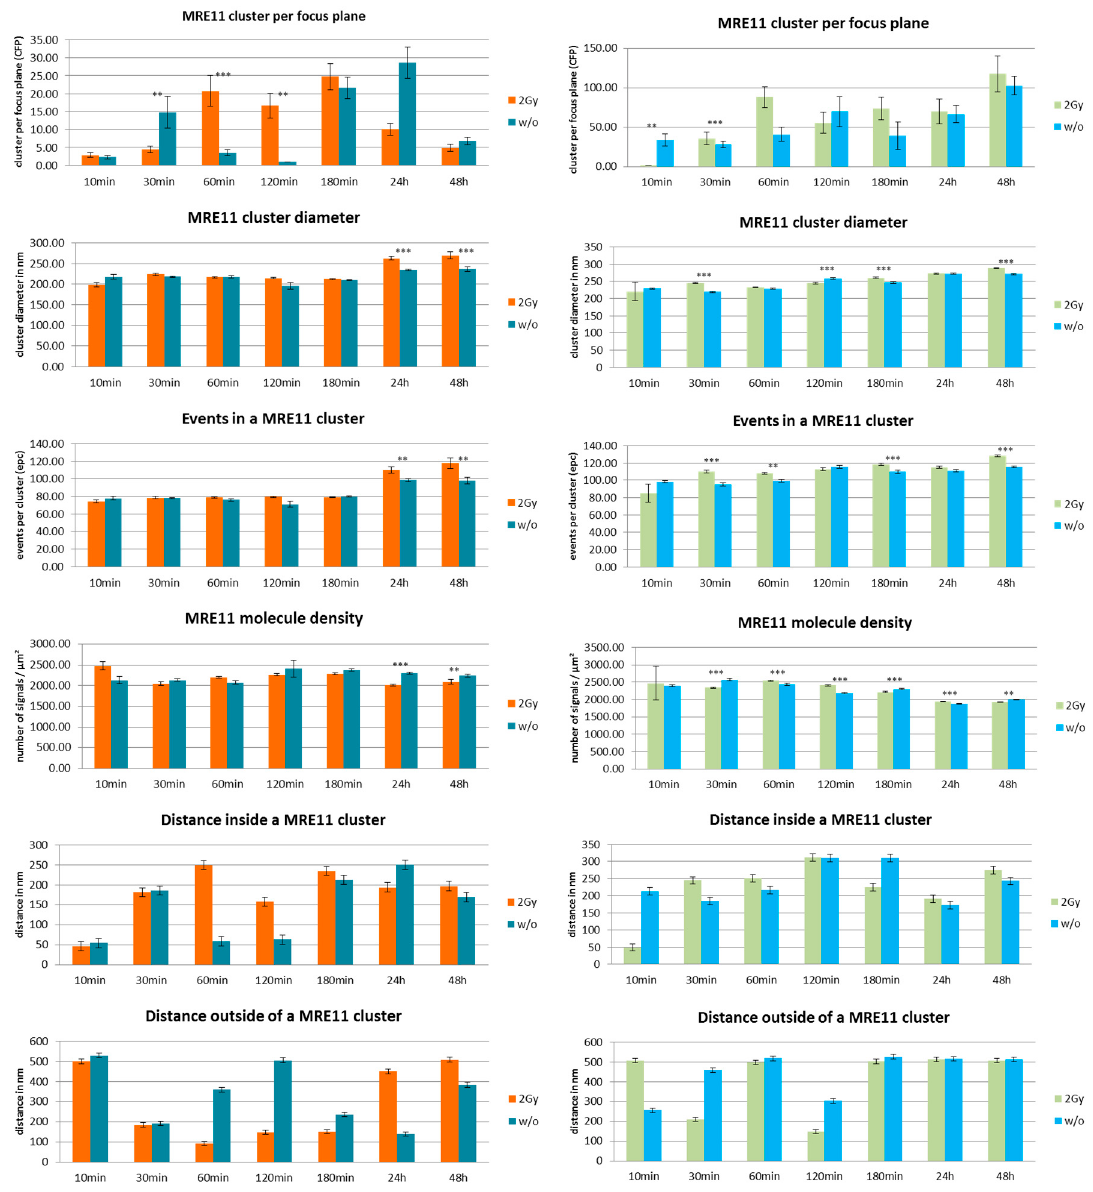
Figure 4. Overview of the results obtained from SMLM measurements. Left panels show the data obtained from MCF-7 breast cancer cell nuclei; right panels show the data obtained from cell nuclei of CCD-1059SK fibroblasts. The columns of each panel represent the mean values calculated from 20 nuclei each. The error bars on top of the column indicate the standard deviation. For each time step after the irradiation process, the data are given for cells exposed to 2 Gy low LET ionizing radiation (“2 Gy”) and for cells subjected to the same culturing procedure but not to radiation treatment (“w/o”). Level of significance between the corresponding values for “2 Gy” and “w/o”: *** = 0.1%; ** = 1%. For further details see